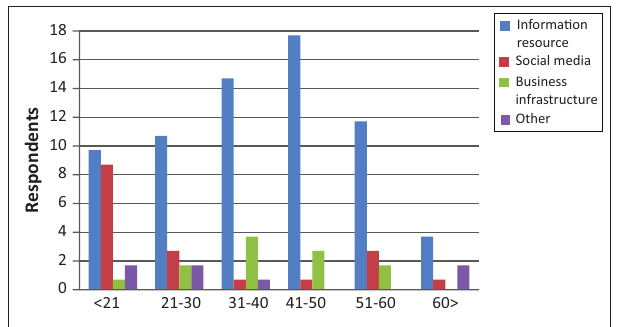
FIGURE 6: Cross-tabulation between age and view of the Web.